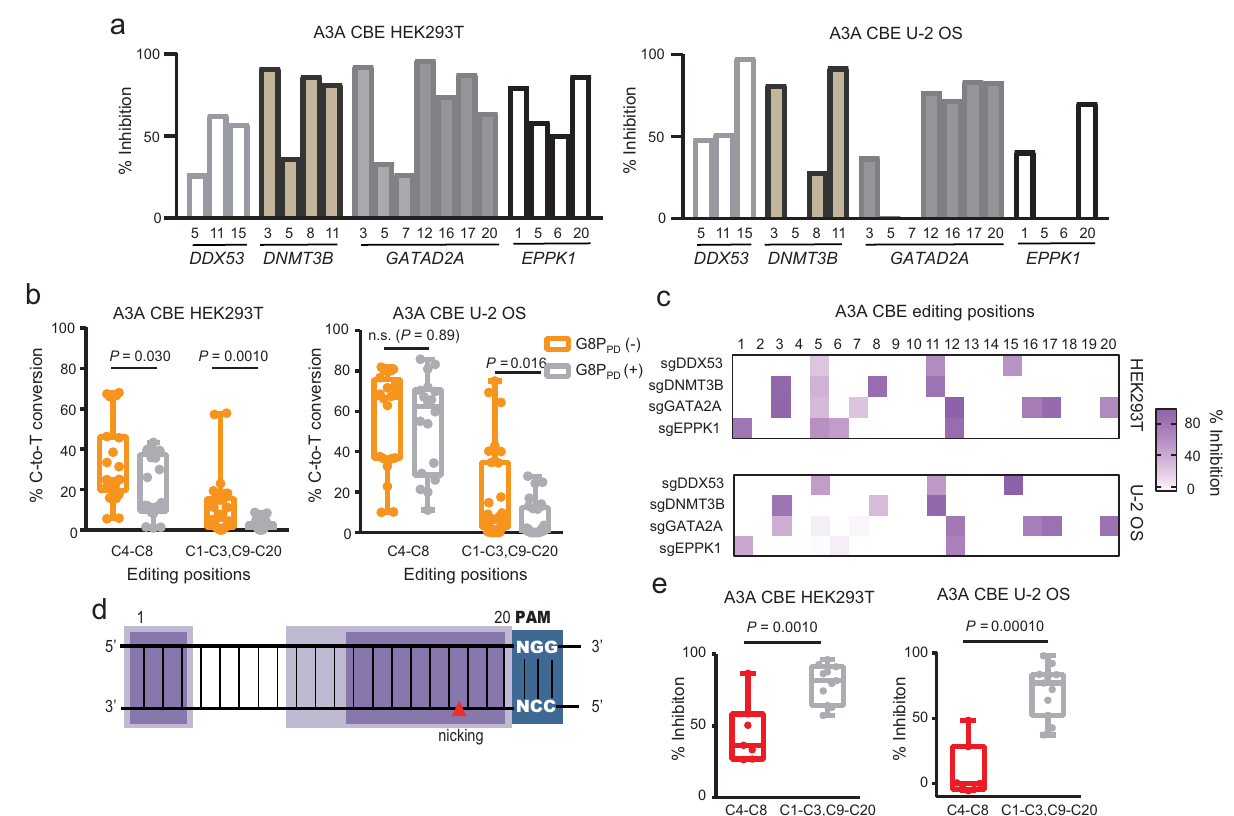
Fig. 2 The inhibitory activities of f1 G8PPD toward A3A CBE at the endogenous genomic sites in human cell lines. a The inhibitory activity of f1 G8P PD toward A3A CBE in HEK293T and U-2 OS cells. b Position-dependent inhibitory activity of G8P PD at on-target and out-of-window editing positions of A3A CBE. c Heat map showing position-dependent inhibition of A3A CBE by G8P PD. d Schematic presentation of the canonical out-of-window position of CBEs (light purple) and the hot spots of G8P PD inhibition (dark purple). The data are derived from Fig. 2c. PAM sequences are highlighted in blue. e Comparison of the inhibition rates of G8P PD at the on-target and out-of-window editing positions of A3A CBE. For a – e , DDX53 and EPPK1 groups contain 2 biologically independent replicates and DNMT3B and GATAD2A groups contain 3 biologically replicates. For b and e , the center line in each box indicates the median. The lower and upper bounds of each box represent the fi rst quartile (25%) and the third quartile (75%), respectively. The bottom and top of whiskers denote the minimum and maximum, respectively. Signi fi cant difference is determined using two-tailed Student ’ s t test. n.s., not signi fi cant. Source data are provided as a Source Data fi positions 4 to 8, the canonical on-target positions of CBEs (Fig. 2b), than at out-of-window positions. The hot spots of G8P PD -mediated inhibition had signi fi cant overlap with the canonical out-of-window editing positions of CBEs (Fig. 2d).